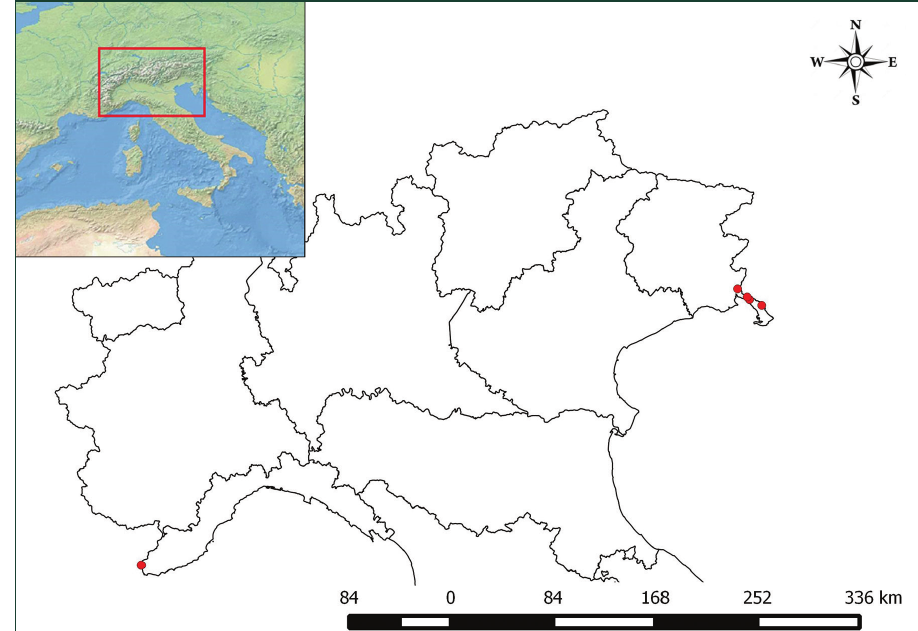
Figure 12. Distribution map of Viola jordanii in Italy. Distribution: Countries of occurrence: Bulgaria, France, Greece, Hungary, Iran, Italy, Macedonia, Moldova, Romania, Serbia, Turkey,